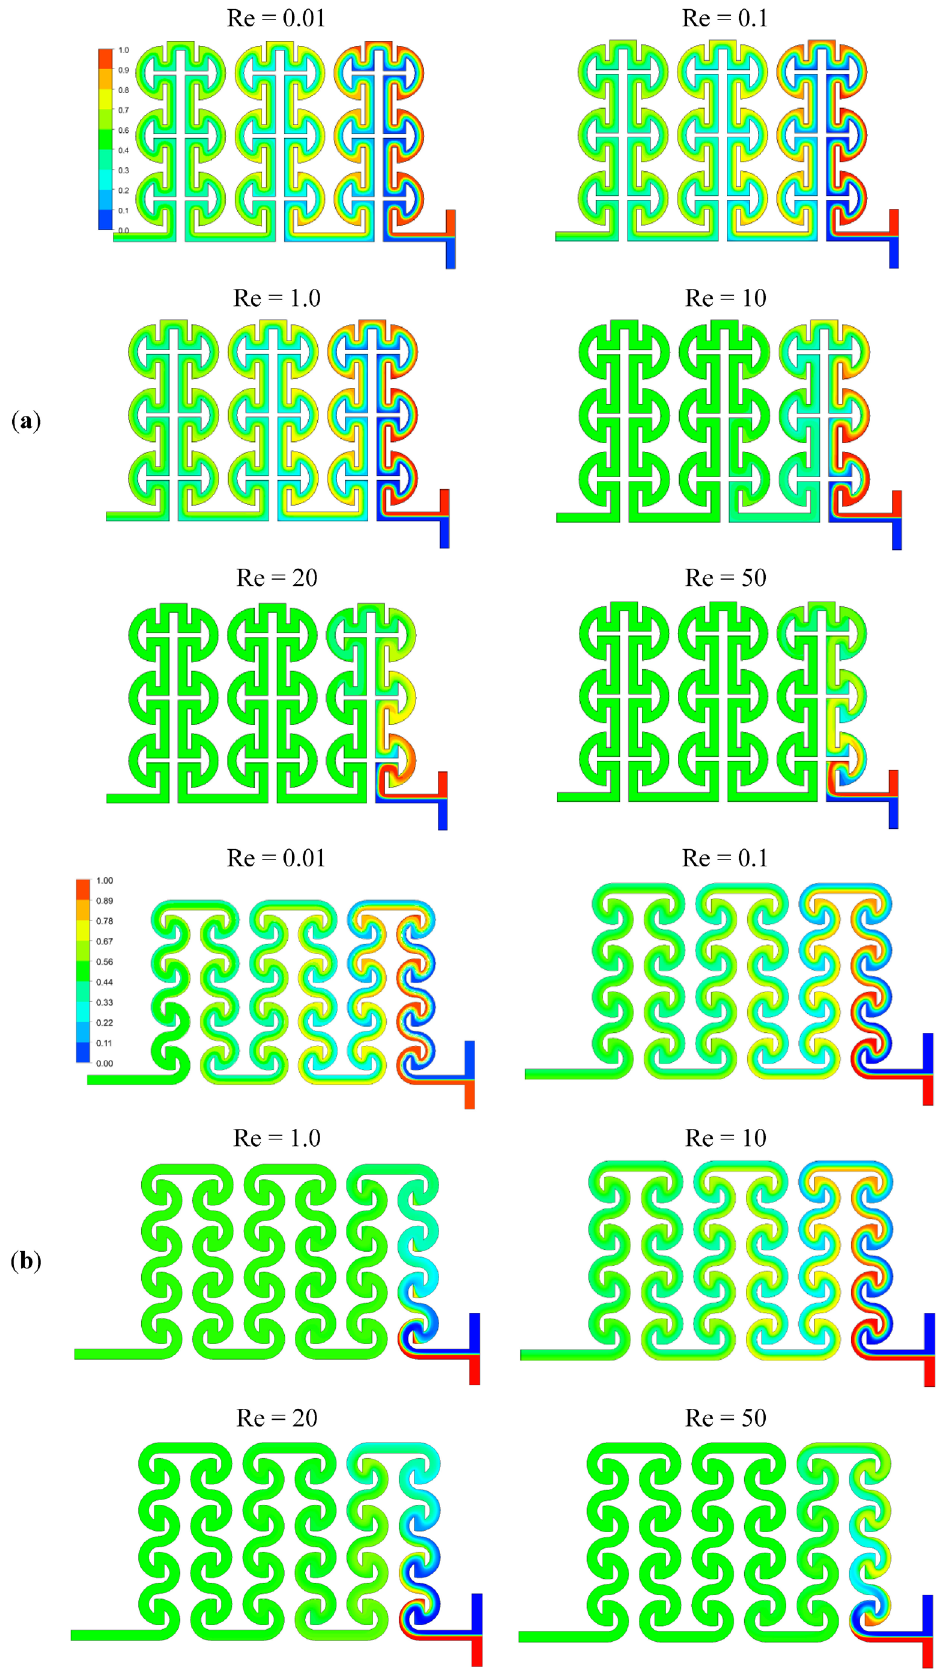
Figure 6 . The species mass fraction contours taking at a mid-plane in the ( a ) Ω micro -channel and ( b ) ILSC micro-channel. Sequence of increasing Reynolds number: 0.01, 0.1, 1, 10, 20,